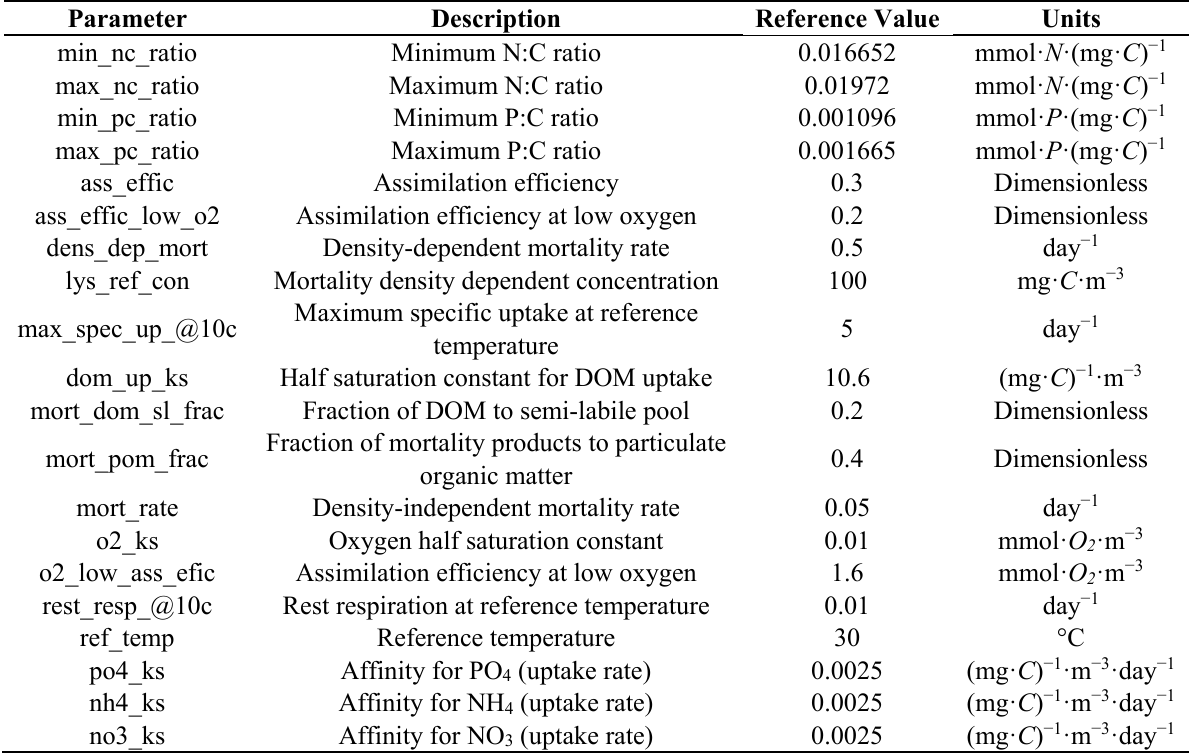
Table 4. List of parameters for decomposer (bacterioplankton).